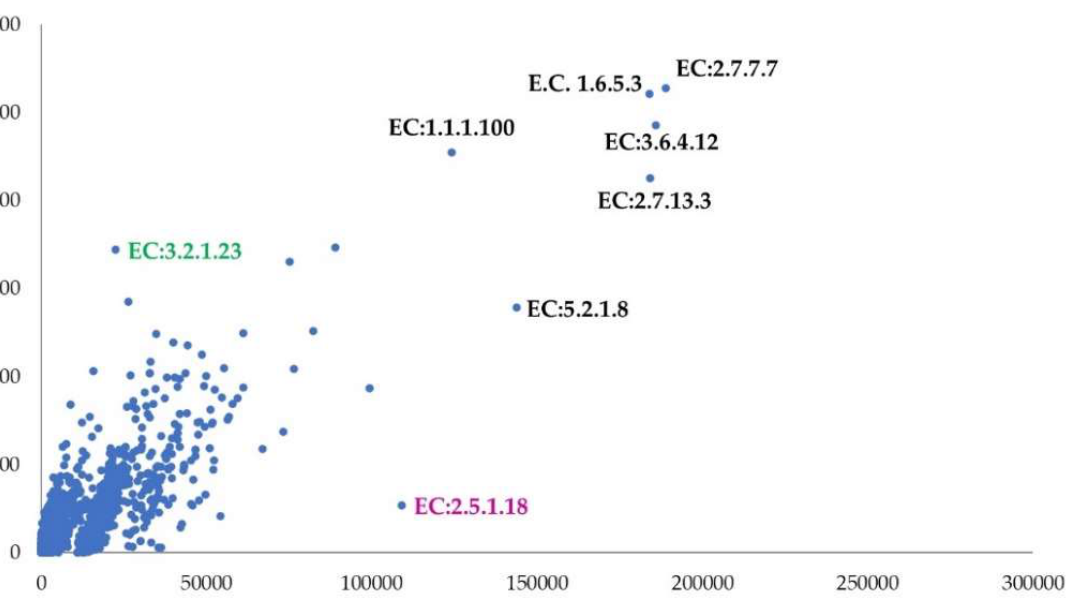
Figure 5. Correlation plot on functional orthologs predicted by PICRUSt 2 software (nodule y axis and rhizosphere x axis). In Figure the KO codes refer to the KEGG Orthologs of KEGG database. Only KOs with relative counts higher than 100,000 were labeled in black. The label in magenta shows the KO with higher counts in rhizosphere. Correlation coefficient: 0.73.